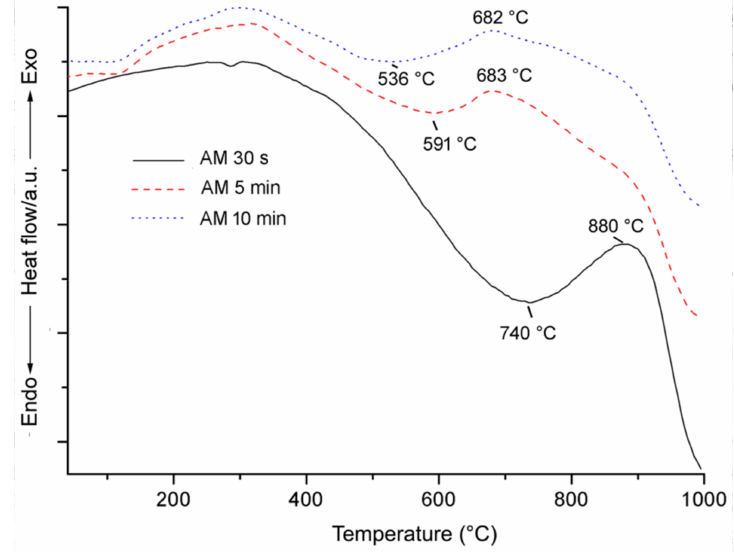
Figure 6. Differential scanning calorimetry of amosite after 30 s, 5 min and 10 min of